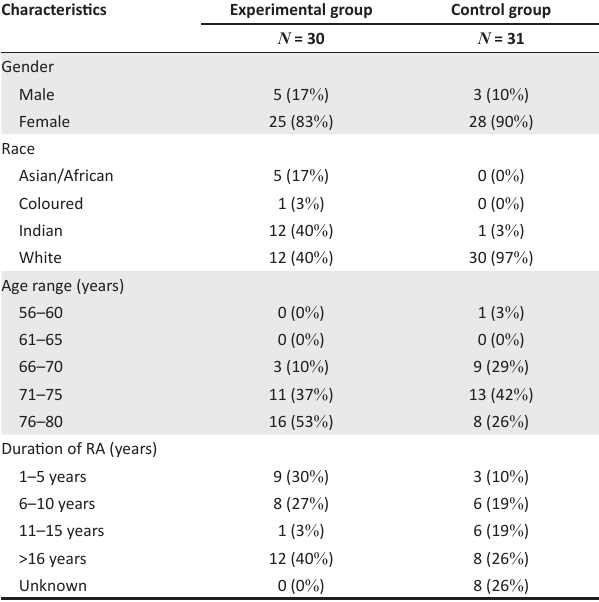
TABLE 2: Profile of participants in experimental and control groups. Characteristics Experimental